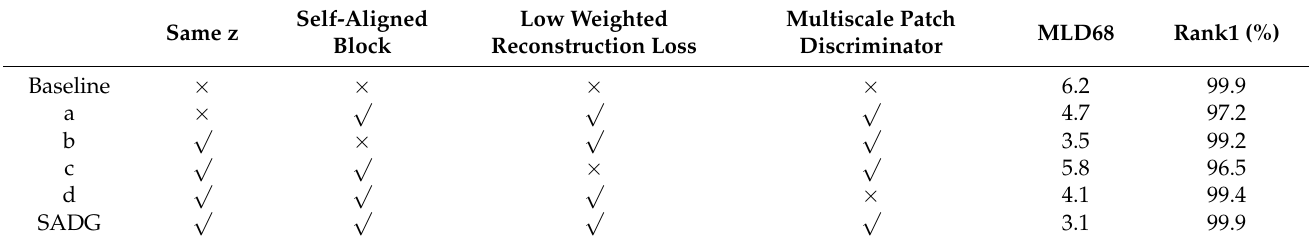
Table 3. Results of the ablation study. a: the same z value; b: without the self-aligned block; c: normal weighted reconstruction loss; d: without a multiscale patch discriminator.